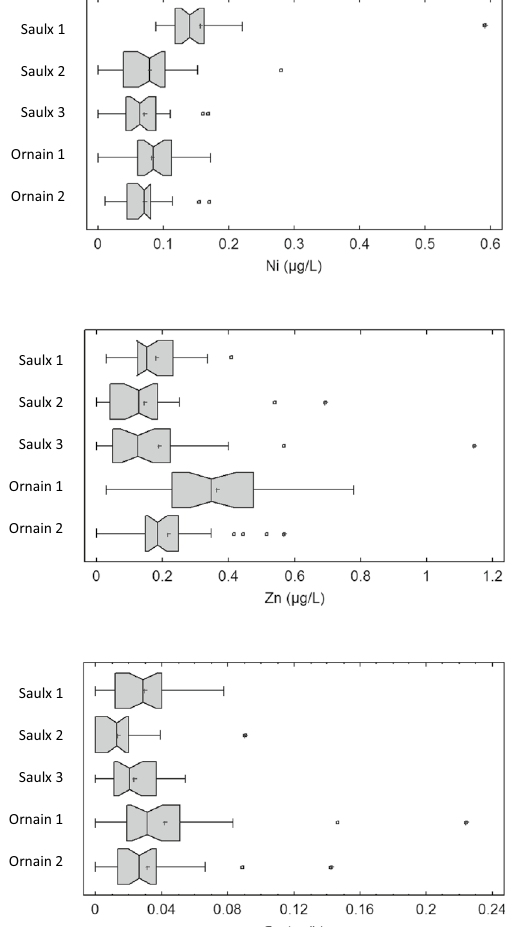
Fig. 3 Box plot of time weighted average concentrations of a selec- tion of metals (Ni, Zn and Cu) and PAHs (fluorene, phenanthrene and pyrene) at each of the five monitoring stations. Boxes extend from the 25th to the 75th quartile. The median and the mean are